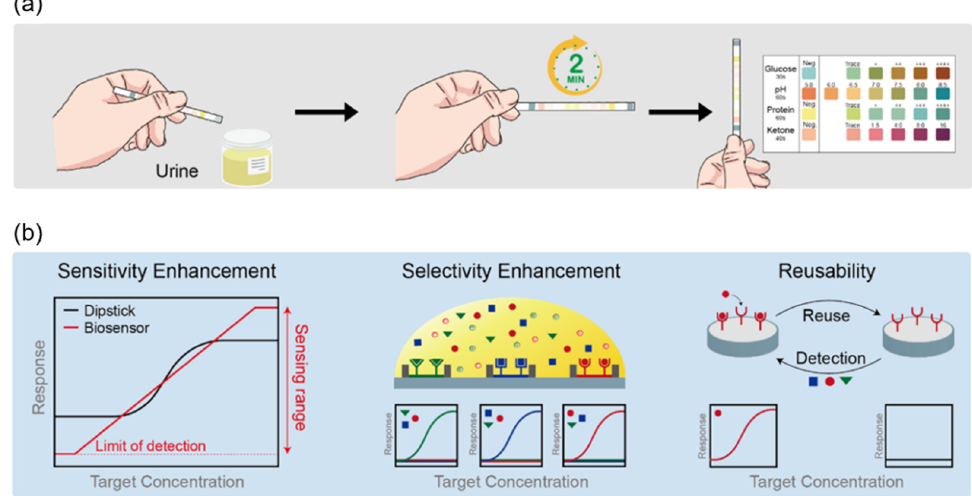
Figure 1. Comparison of point-of-care urinalysis with the dipstick test and biosensor. ( a ) Schematic representation of how to test urine using the dipstick test. ( b ) Schematic representation of the advantages of using a biosensor for urinalysis, enabling improved sensitivity, selectivity, and reusability compared with those of the dipstick test. Table 1. Summary of biosensors developed to identify urine ‐ based biomarkers that are typically detected by dipstick tests.